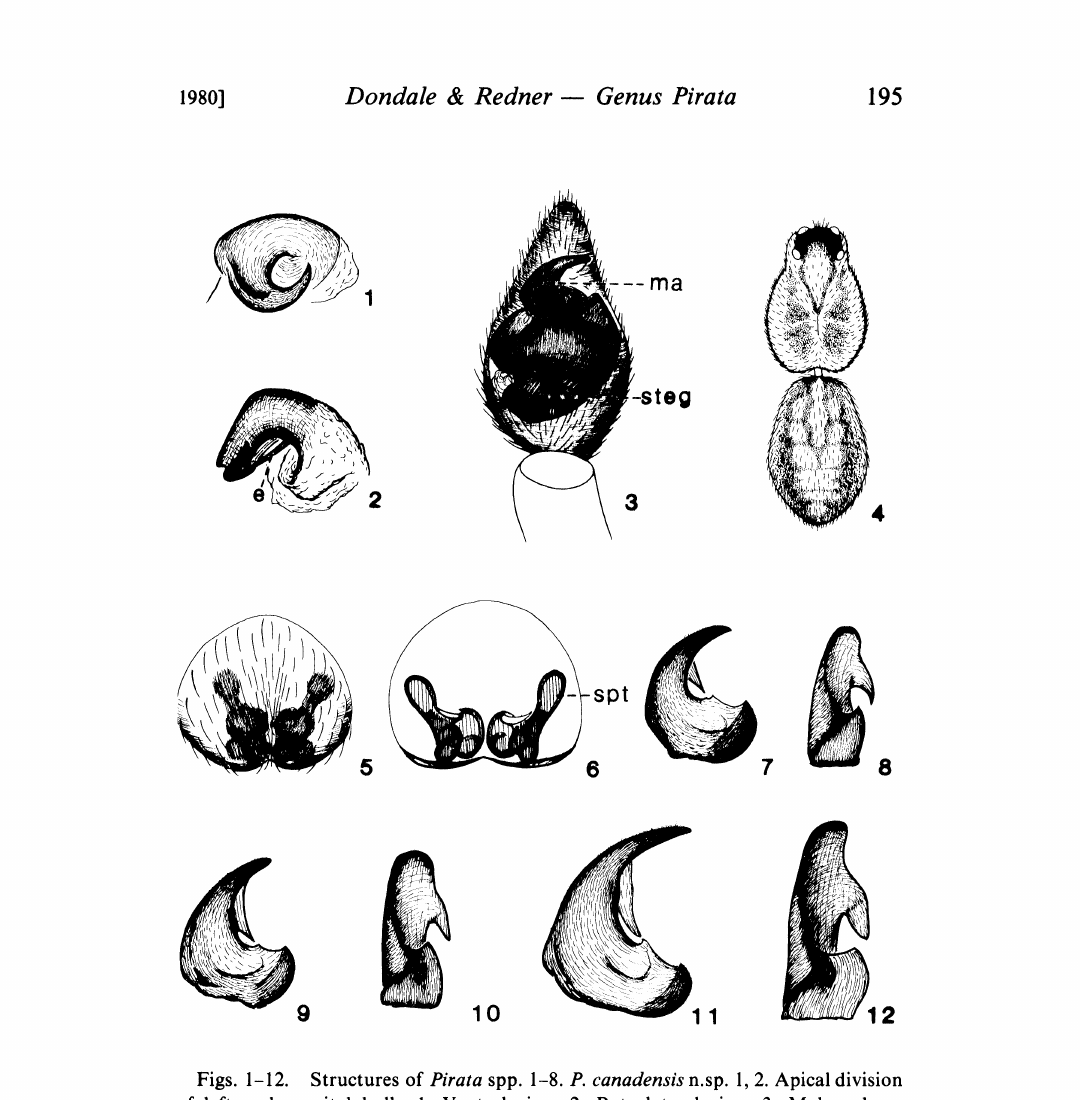
Figs. 1-12. Structures of Pirata spp. 1-8. P. canadensis n.sp. 1, 2. Apical division of left male genital bulb. 1. Ventral view. 2. Retrolateral view. 3. Male palpus, ventral view. 4. Body of female, dorsal view. 5. Epigynum, ventral view. 6. Epigy- num, dorsal view, cleared. 7, 8. Median apophysis. 7. Ventral view. 8. Retrolateral view. 9, 10. Median apophysis of P. cantralli Wallace and Exline. 9. Ventral view. 10. Retrolateral view. 11, 12. Median apophysis of P. insularis Emerton. 11. Ventral view. 12. Retrolateral view. e, embolus, ma, median apophysis, spt, spermatheca, steg,